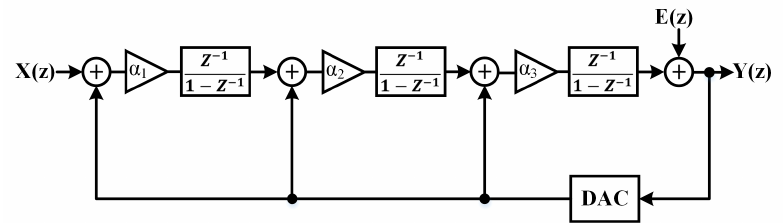
Figure 2. Block diagram of the third-order Sigma-Delta